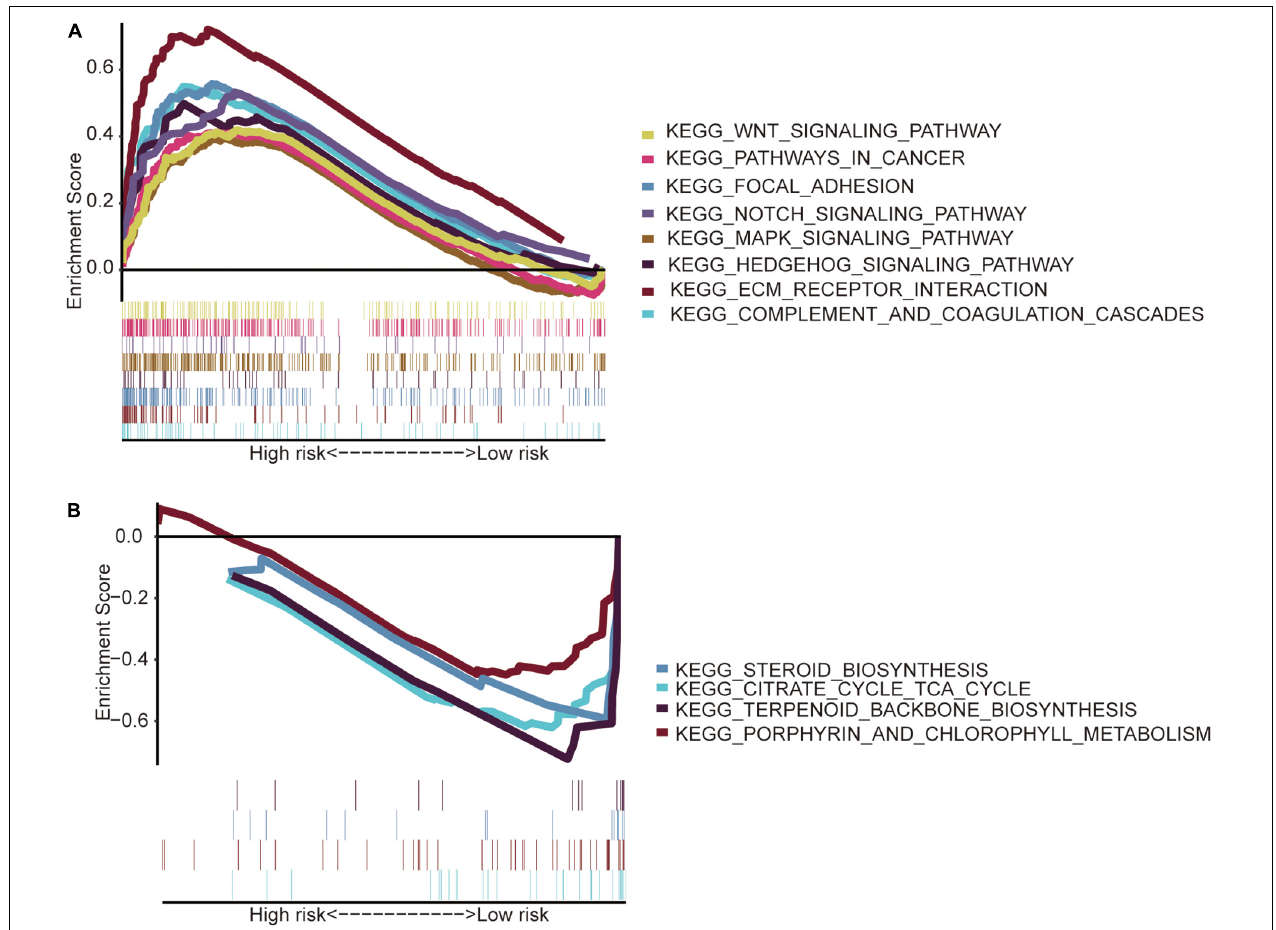
FIGURE 5 | Gene set enrichment analysis. (A) High-risk patients with eight significantly enriched KEGG pathways in the entire TCGA cohort by GSEA. (B) Four significantly enriched KEGG pathways in the low-risk patients were analyzed by GSEA in the entire TCGA cohort.